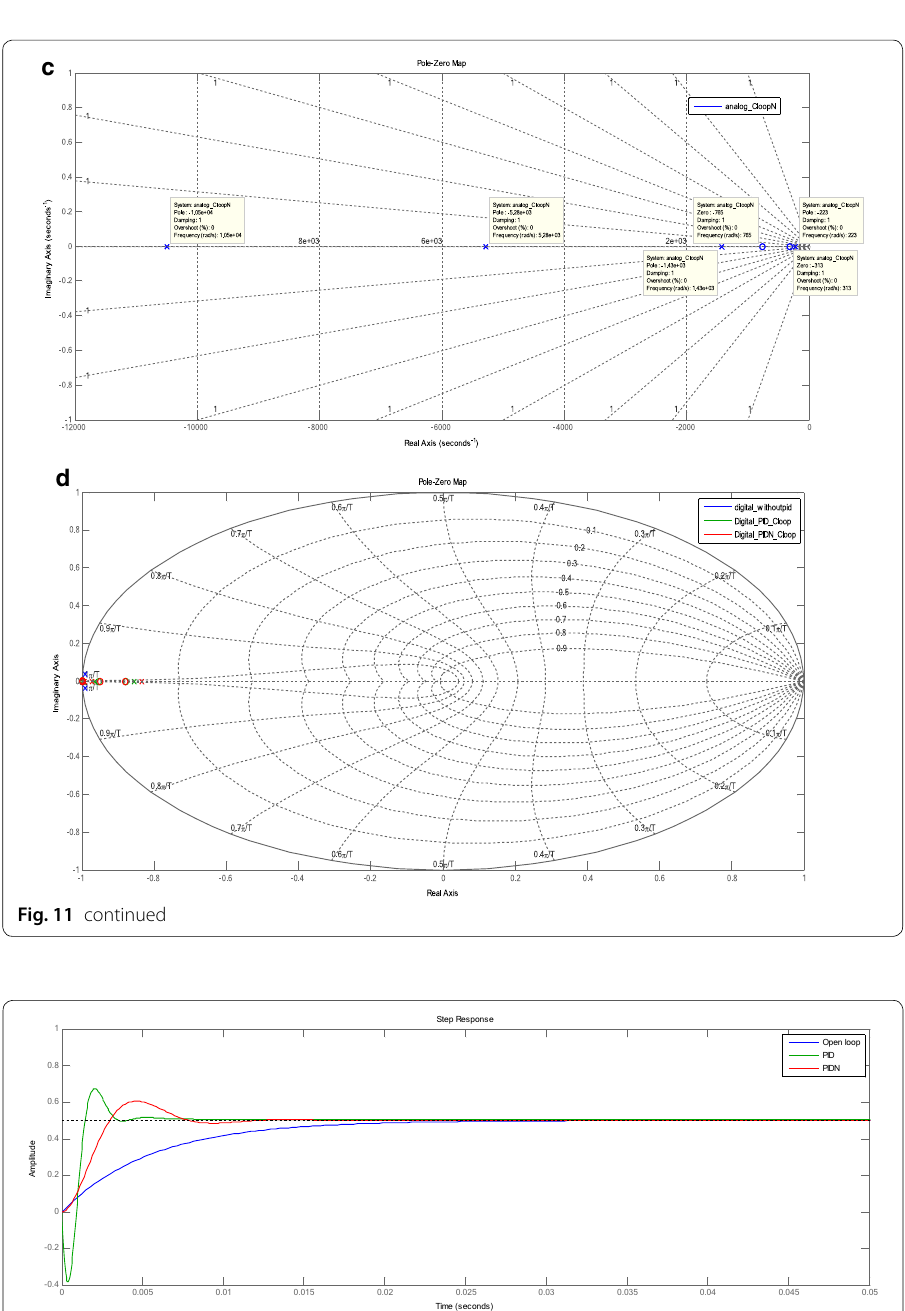
Fig. 12 Step response of BBC in buck mode for 50% duty cycle